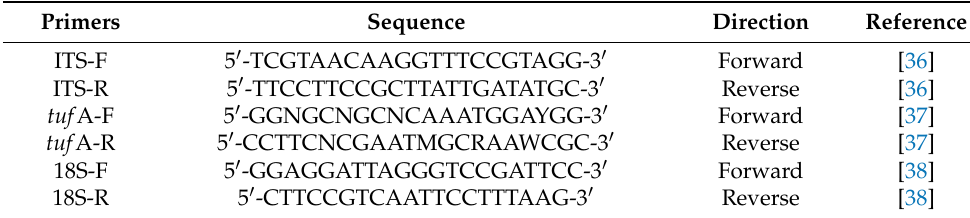
Table 1. Polymerase chain reaction primers used in the